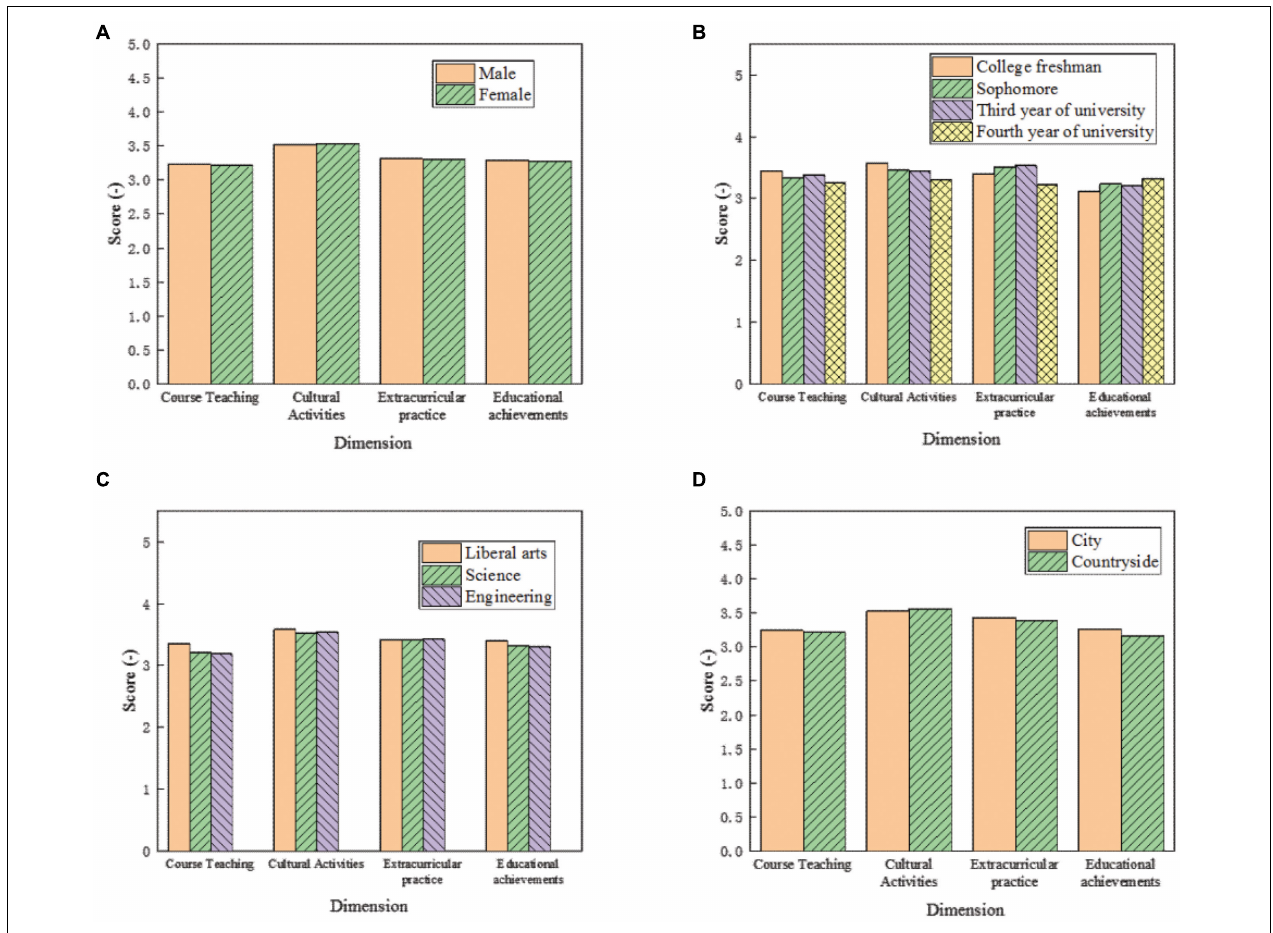
FIGURE 9 | Cultural diversity cultivation of different types of college students. The scores of cultural diversity cultivation of students with different (A) genders, (B) grades, (C) subjects, and (D) family situations are shown. students with different genders, grades, subjects, and family situations,